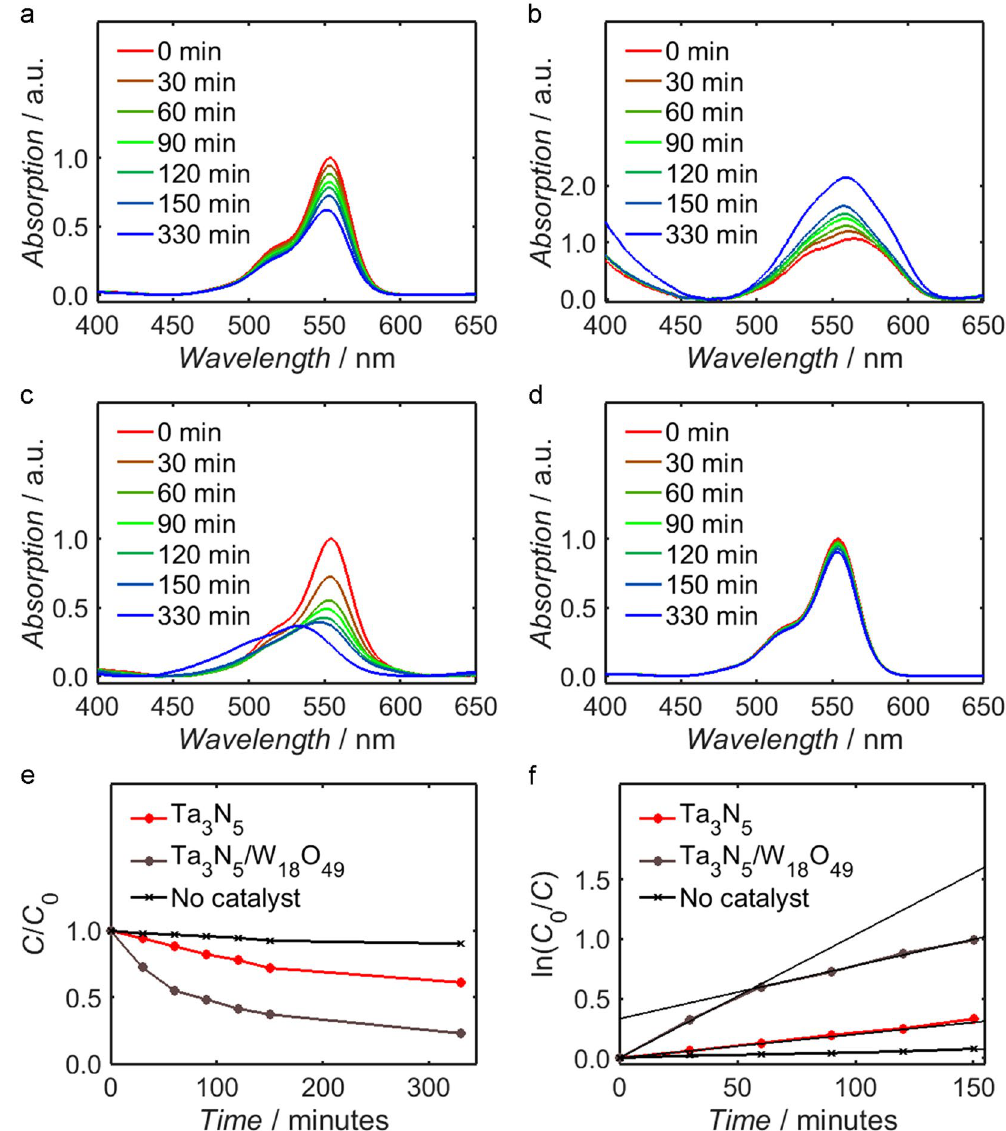
Figure 8. UV-Vis absorption spectra of supernatant extracted from white light illuminated suspensions of Ta 3 N 5 ( a ), W 18 O 49 ( b ) and Ta 3 N 5 /W 18 O 49 ( c ) in Rhodamine B solution (0.02 mM), as well as a control solution containing no catalyst ( d ). For Ta 3 N 5 , Ta 3 N 5 /W 18 O 49 and the control solution, the progression of absorption at 554 nm, C , is plotted as a function of white light illumination time in ( e ), normalised with respect to the value of C prior to illumination, C 0 . The ratio C 0 / C is also plotted logarithmically for these samples in ( f ). The plots show that while W 18 O 49 had no observable catalytic effect on dye oxidation, Ta 3 N 5 /W 18 O 49 photocatalysed the reaction at over double the rate of Ta 3 N 5 on its own. The composite also yielded the highest rate of N-deethylation, as shown by the pronounced hypsochromic shift of the absorption peak in ( c